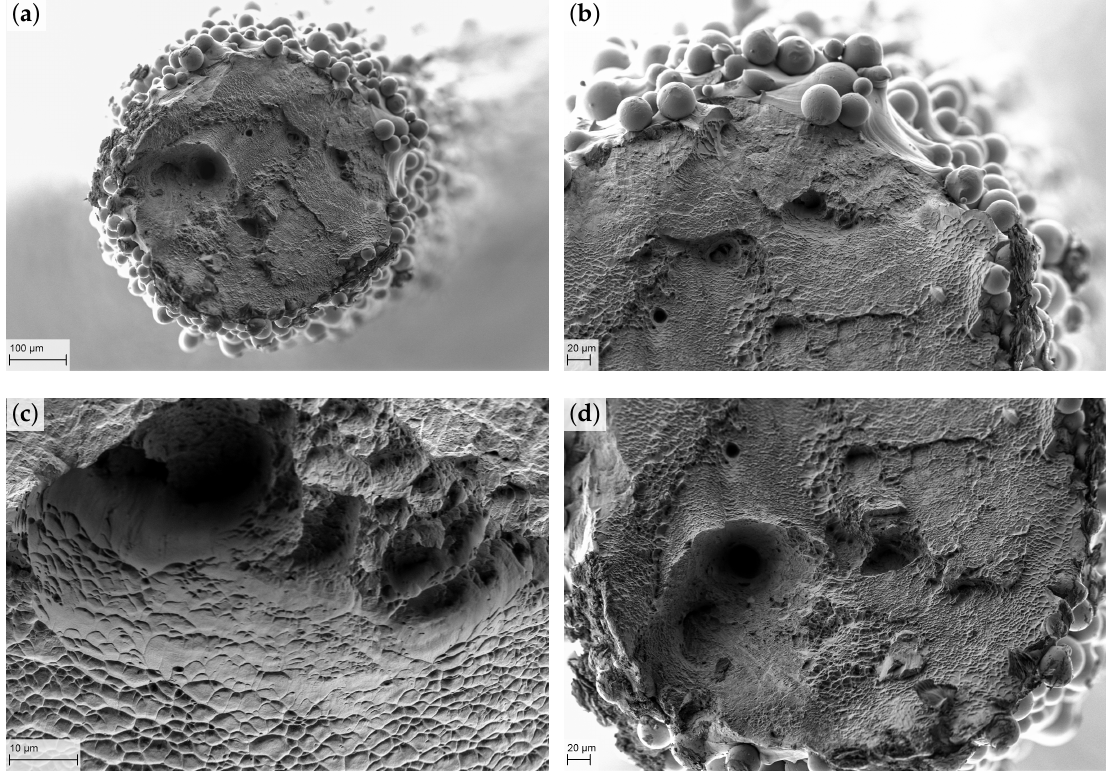
Figure 4. SEM analysis of the support sample L10D06S. ( a ) Fracture surface with 250 × magnification. ( b ) Brittle and ductile regions at 500 × . ( c ) Micro-dimpled surface at 3000 × . ( d ) Mixed fracture at 500 ×